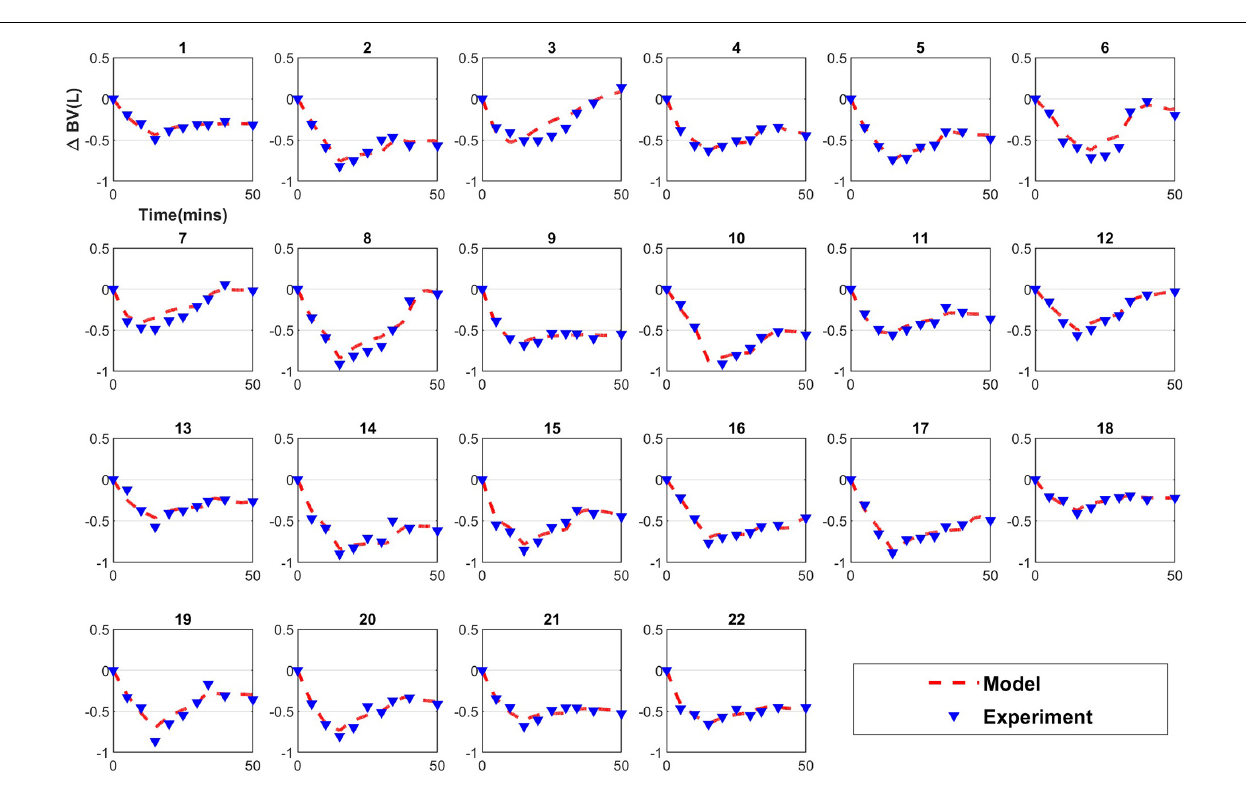
infusion could start at 30 min. Identifiability of K p could